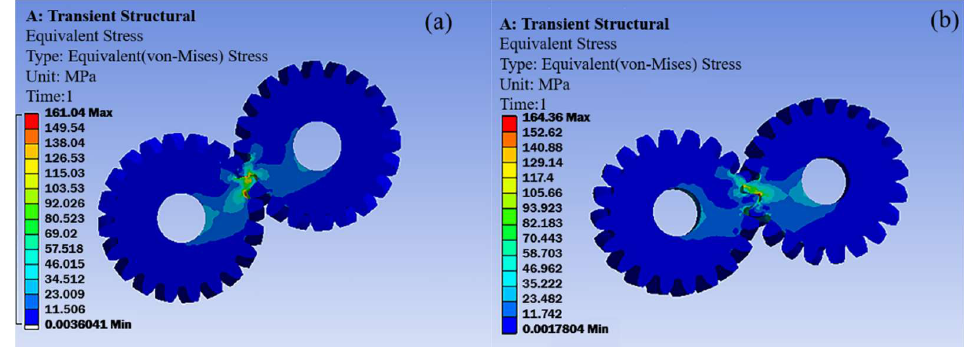
Figure 3. Stress distribution cloud chart ( a ) maximum equivalent stress of prototype gears, ( b ) maximum equivalent stress of model gear.